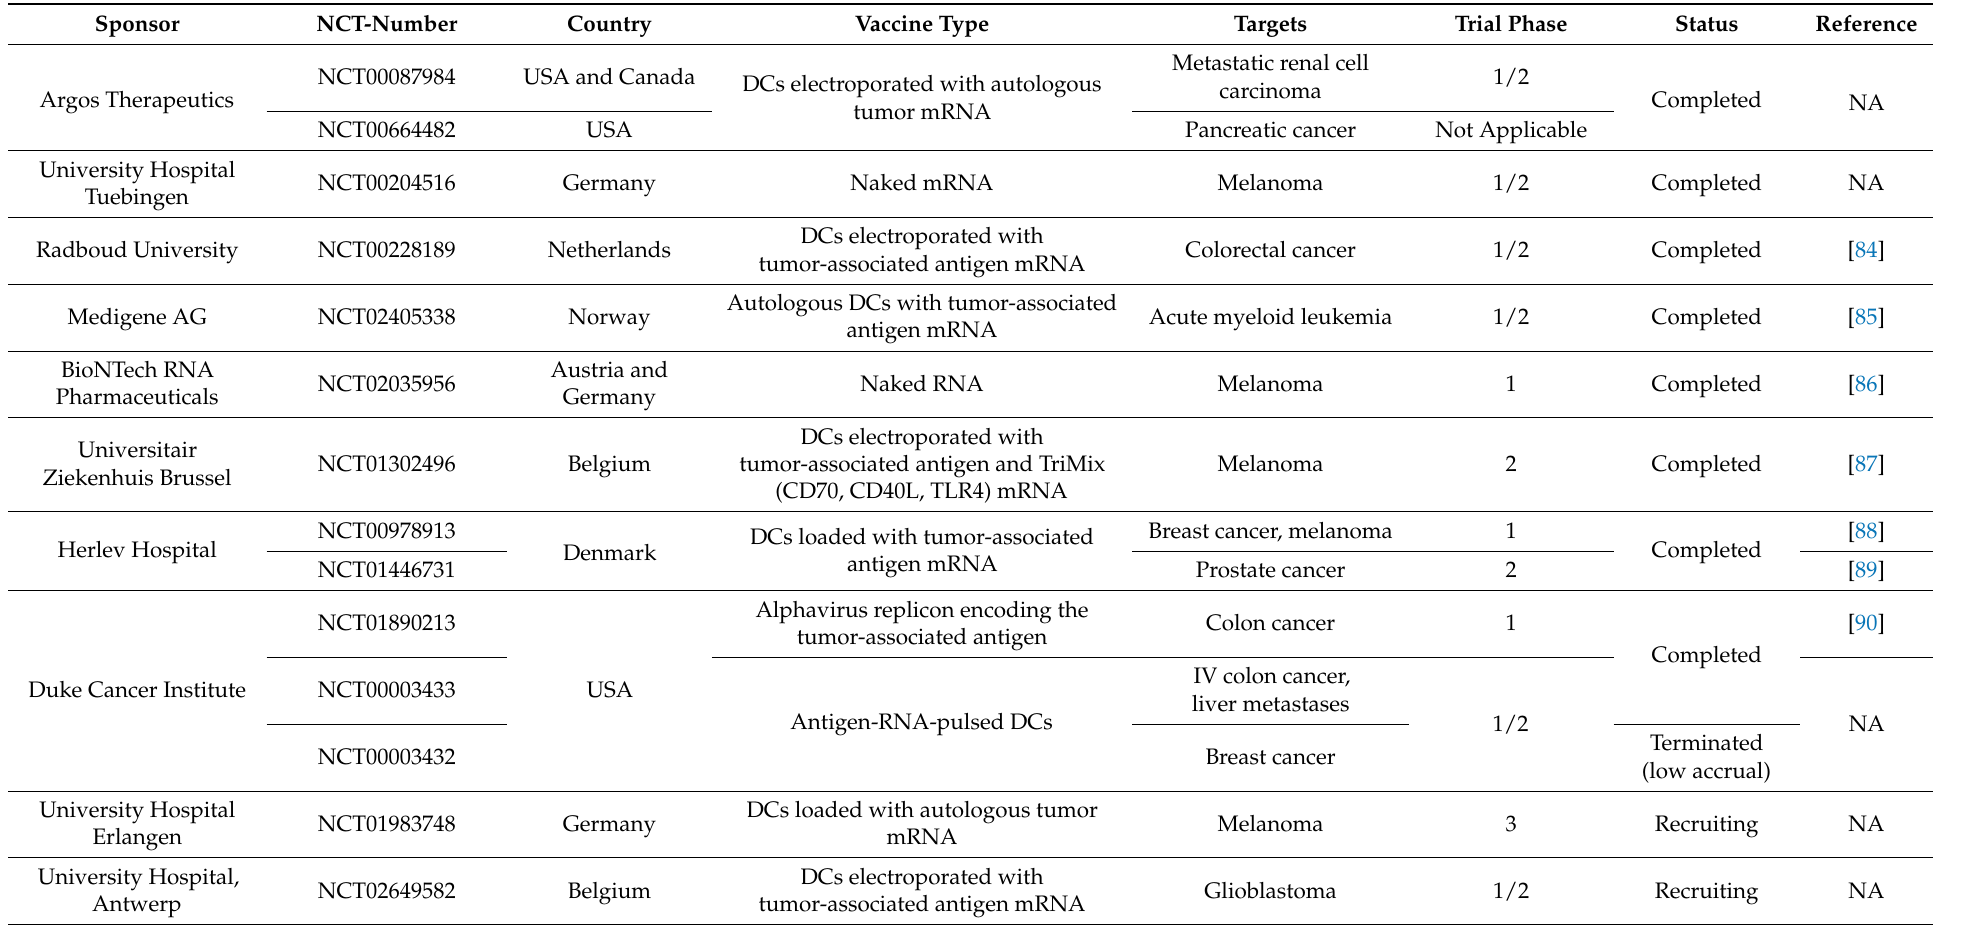
Table 1. Clinical trials with RNA-based vaccines against cancer. Data collected from the studies registered at ClinicalTrials.gov as of 8 August